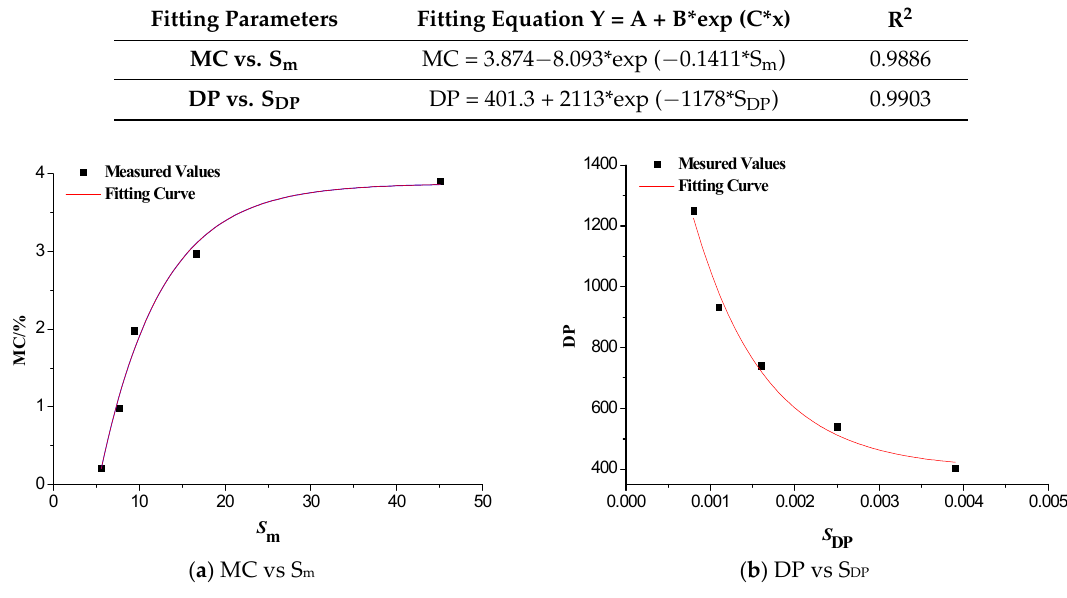
Figure 4. Fitting curves between characteristics and oil-paper stutas.